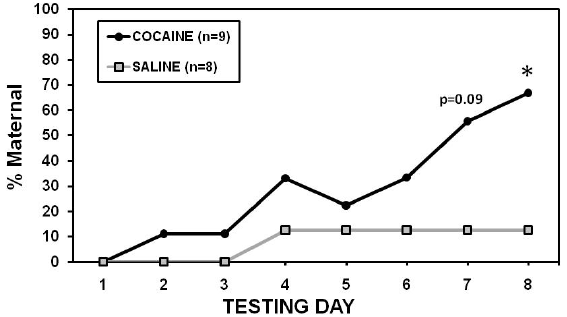
Figure 2. Percentage of saline and cocaine treated nulliparous rats that maternally responded to the presentation of foster pups over 8 days of continuous pup exposure. * Indicates a significant difference between saline and cocaine treated rats ( p < 0.05).